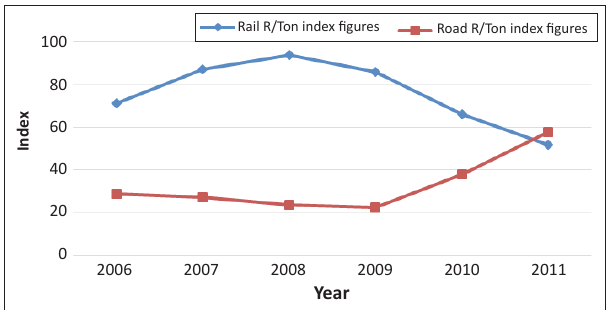
FIGURE 7: Transport to all customers index figures.